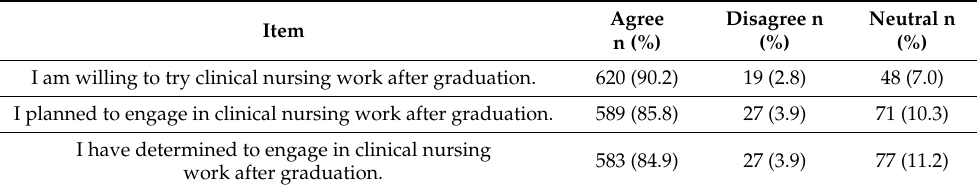
Table 5. Intention to join the nursing workforce in the future (n = 687).